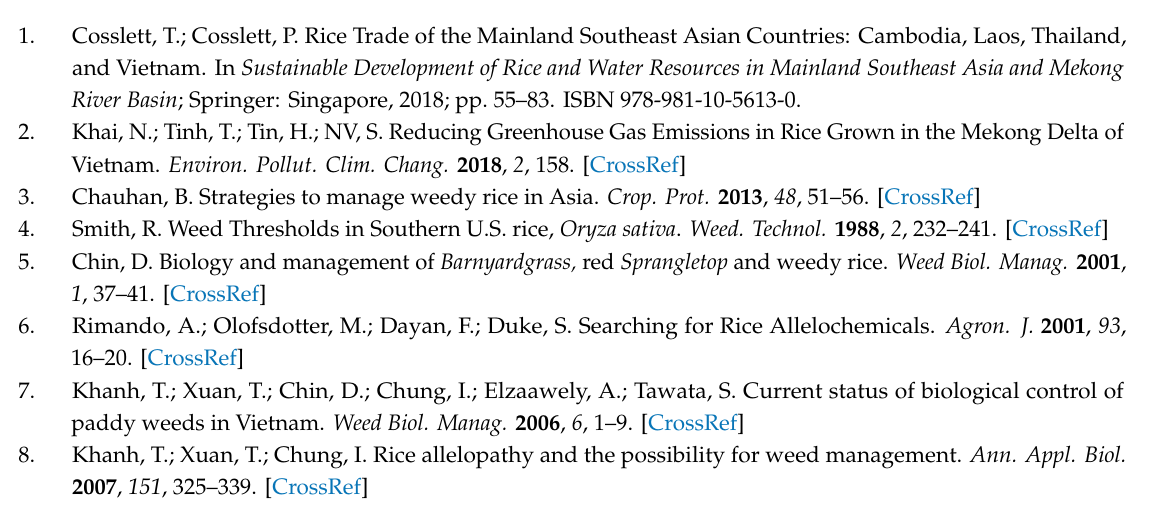
Table S1: Major previously-reported allelochemicals in Oryza sativa L. species, Table S2: Allelochemicals e ff ecting pests detected in 9 OM rice cultivars by XCMS